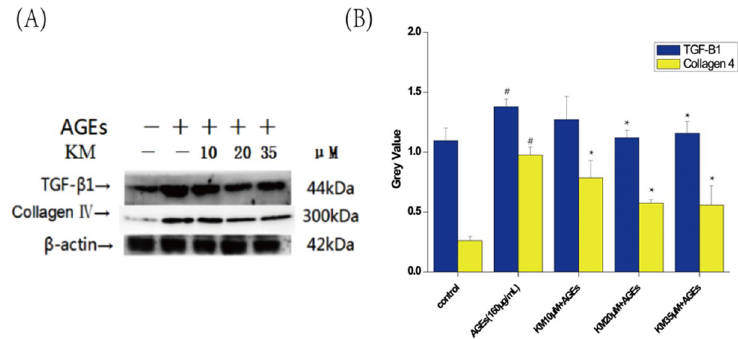
Figure 8. KM treatment reduces the proliferation of the ECM in AGE-treated GMCs. GMCs were treated with AGEs (160 µ g/mL) and KM (10, 20 or 35 µ M). ( A ) The protein levels of TGF- β 1 and Collagen IV were examined by Western blot. + means adding reagents, − means not joining ( B ) The results were presented as mean ± SEM. * p < 0.05, vs. AGEs group; # p < 0.05, vs. control group.